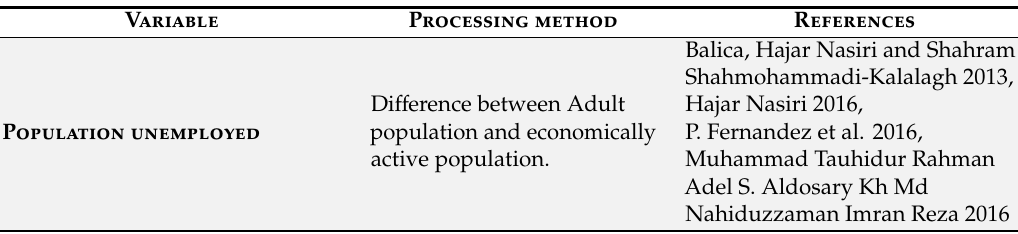
Table 2. Economical component